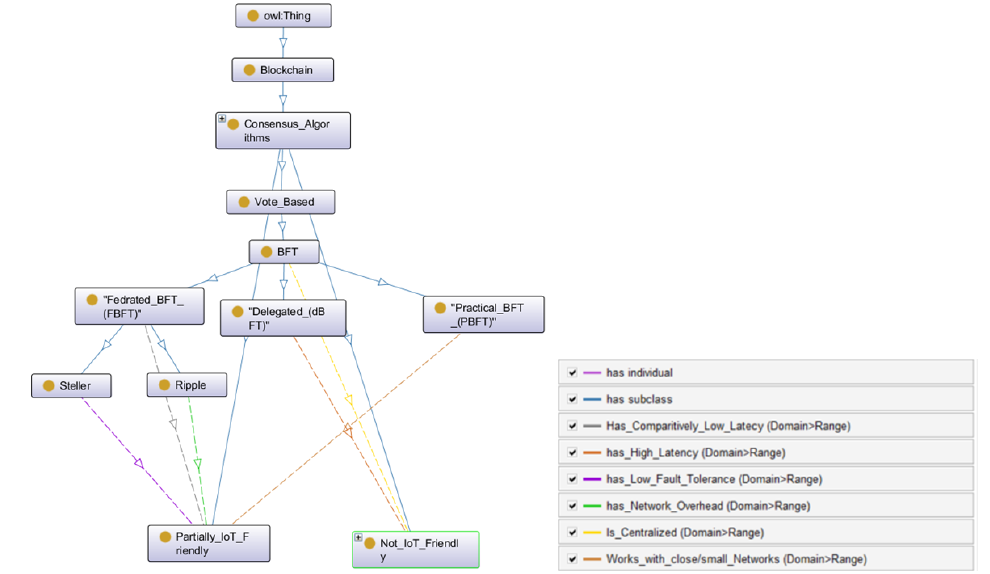
Figure 6. Ontology of vote-based consensus class algorithms and IoT